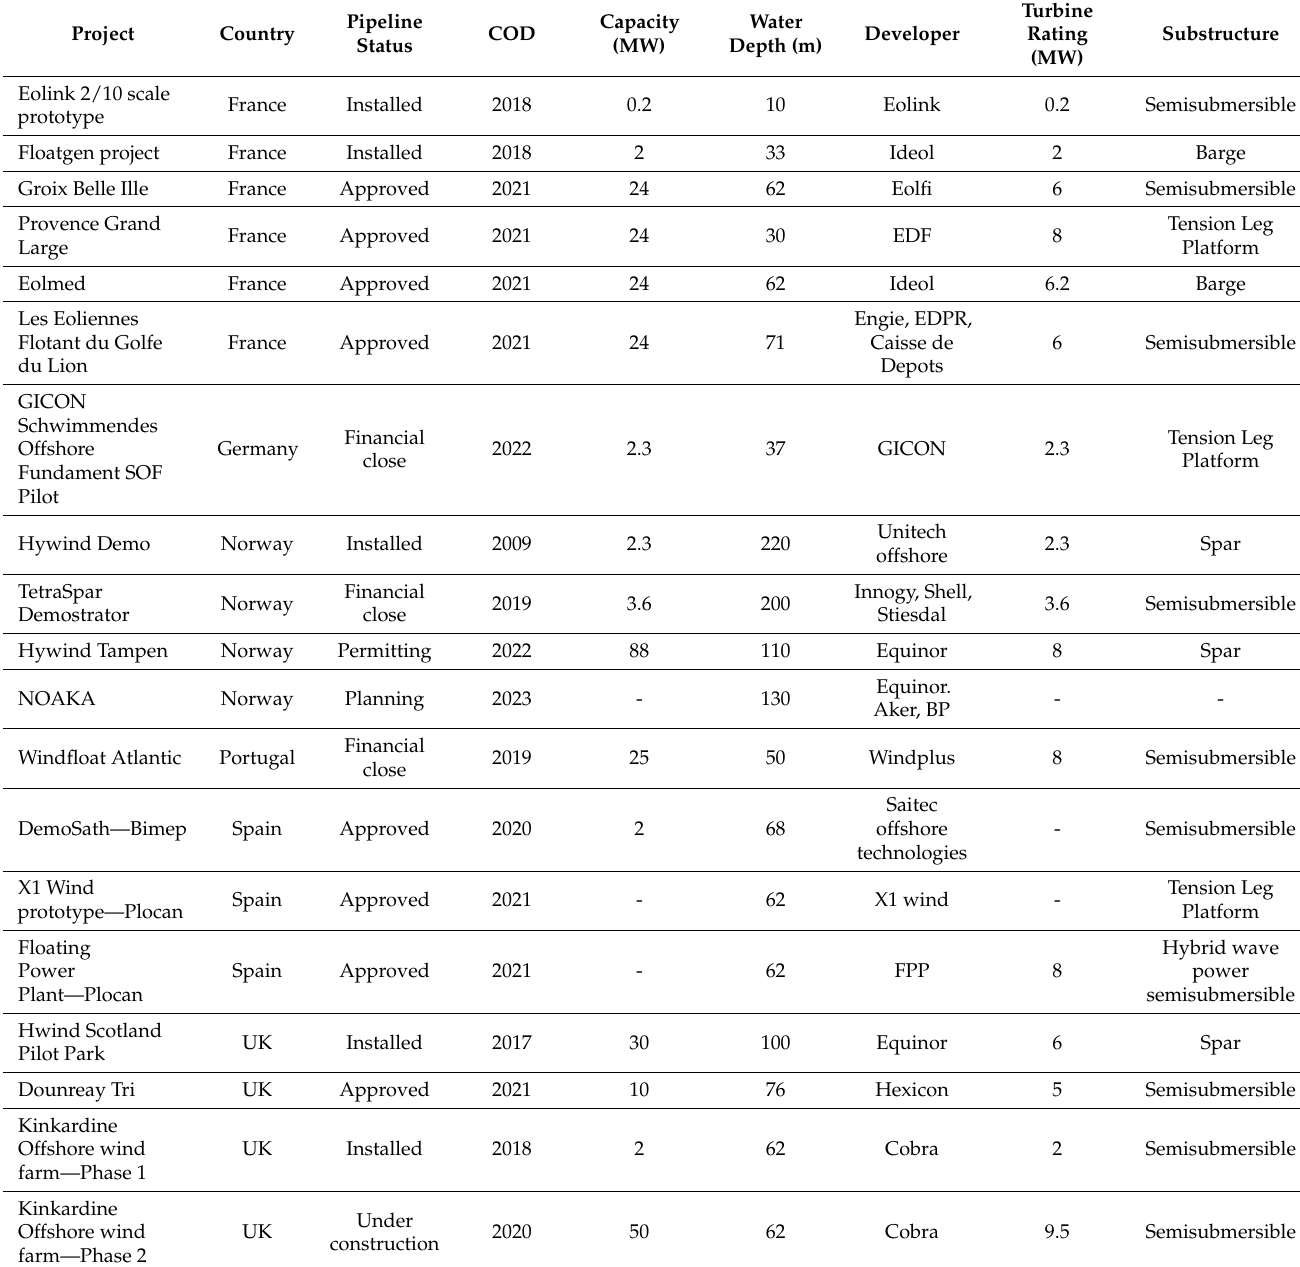
Table 4. Europe floating wind